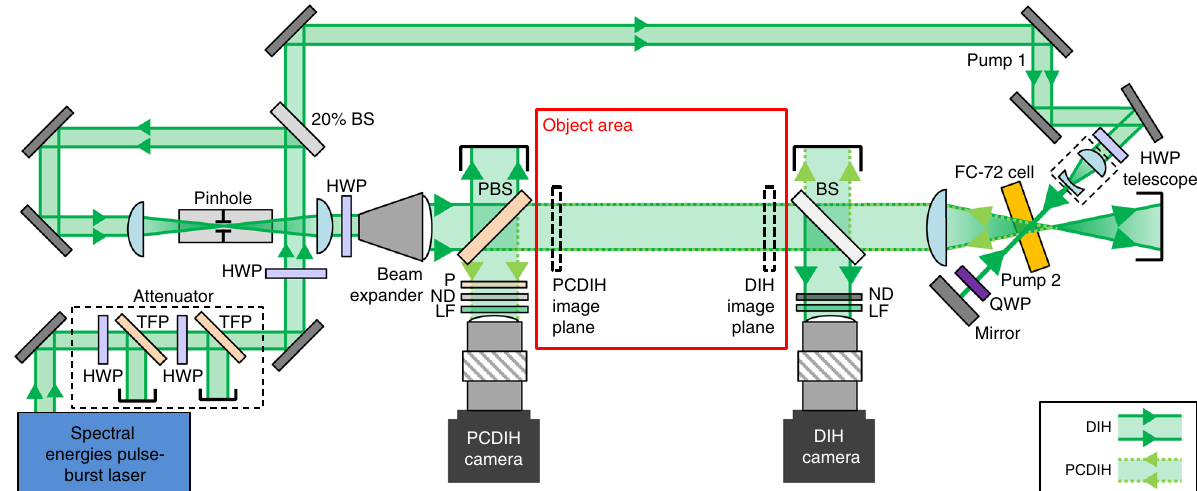
Fig. 2 Experimental con fi guration. Simultaneous DIH and PCDIH using an ultra-high-speed pulse-burst laser is illustrated (HWP — half wave plate, QWP — quarter wave plate, TFP — thin- fi lm polarizer, BS — beam splitter, PBS — polarizing beam splitter, P — polarizer, ND — neutral density fi lter, LF — laserline fi lter with 0.2 nm full width at half